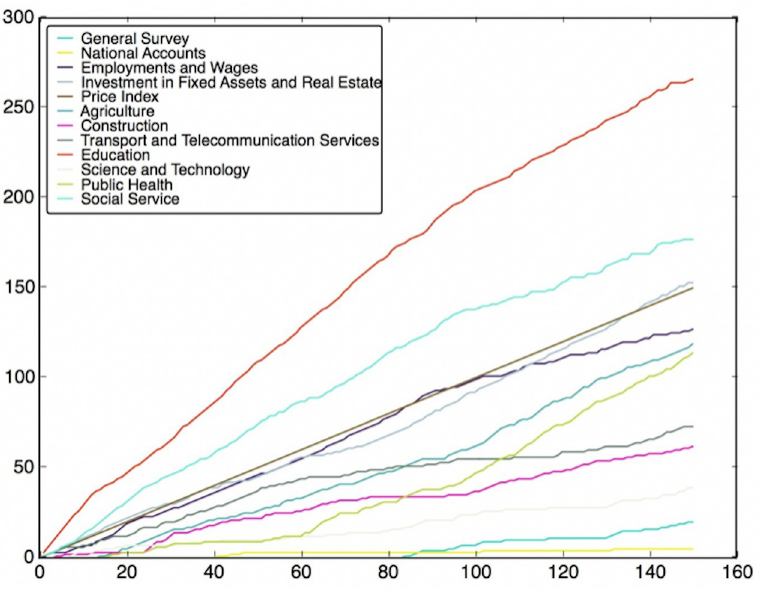
Fig 17. NNR with 10 features and clustering